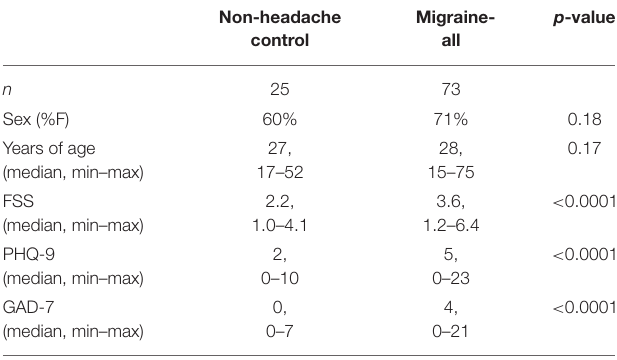
TABLE 1 | Clinical characteristics.